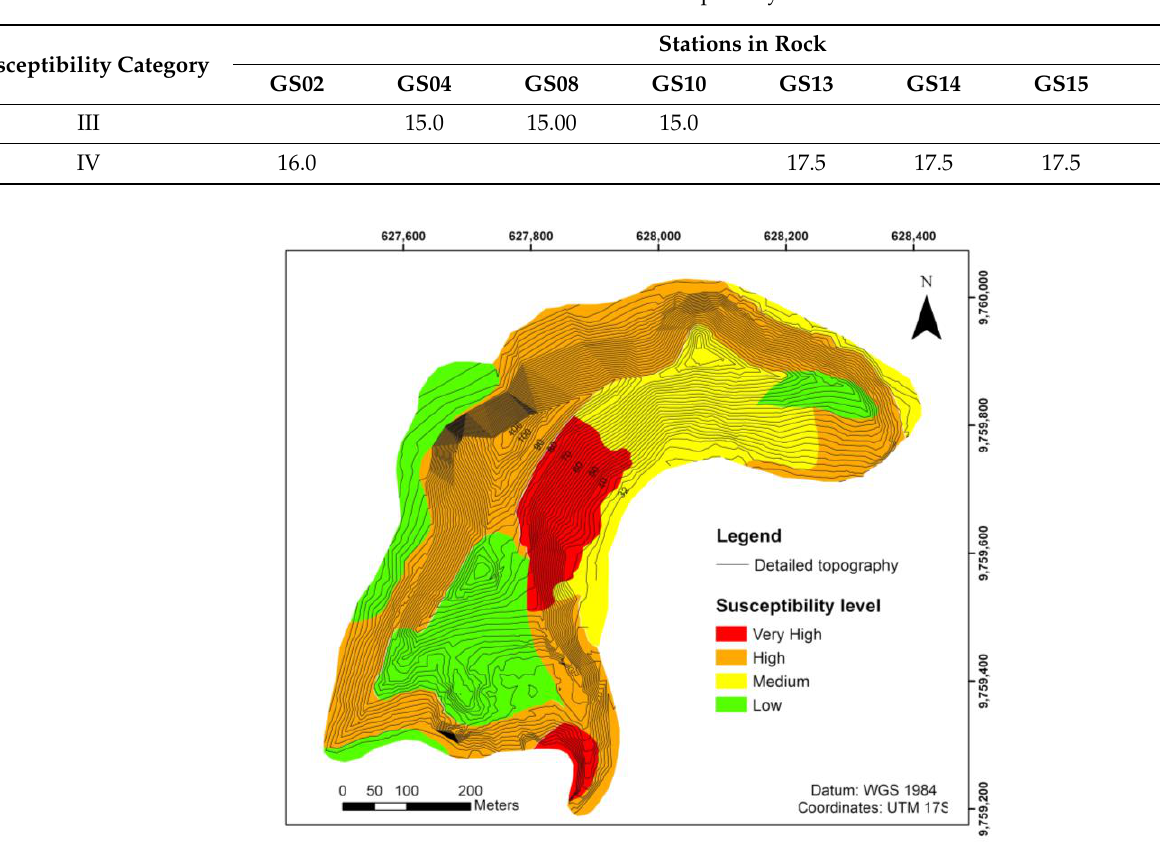
Figure 8. Zoning plan according to susceptibility to landslide and detachment.